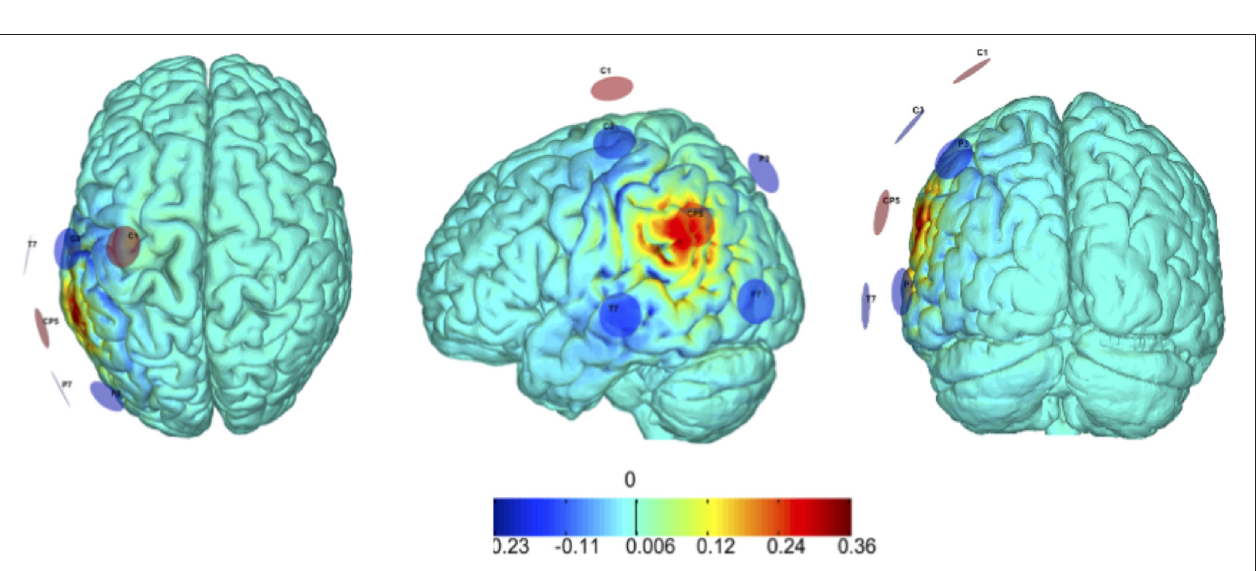
FIGURE 2 | Modeling of electric field induced by tACS. tACS was delivered to the target region (left angular gyrus, BA39/40). Our montage optimization is based on the StimWeaver algorithm ( 29) that revealed that 6 stimulating channels, 2 anodes, and 4 cathodes, provide an optimal montage solution, with the precise stimulation pattern defined using modeling of the induced electric field. By design, the number of active electrodes depended on the optimization but was predefined to be kept always ≤ 8. In keeping with safety guidelines, the max total injected current was set to be < 4.0mA and a maximum current per electrode was set to be <